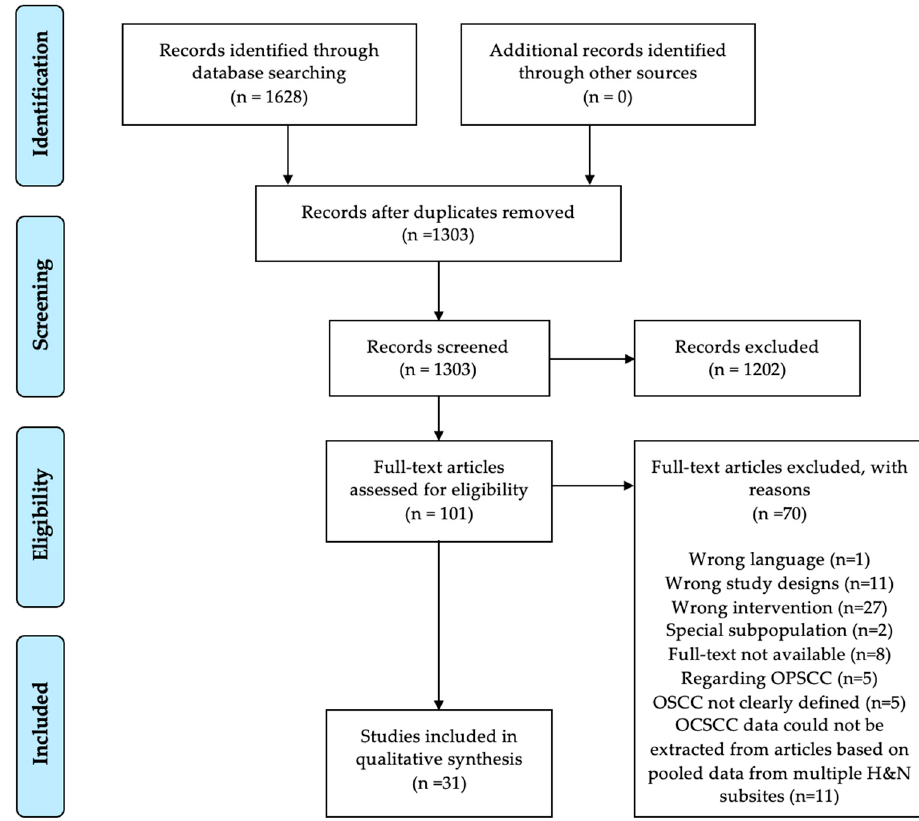
Figure 1. Prisma Flowchart. OCSCC: oral cavity squamous cell carcinoma, OPSCC: oropharyngeal squamous cell carcinoma, OSCC: oral squamous cell carcinoma, H&N: Head and Neck.